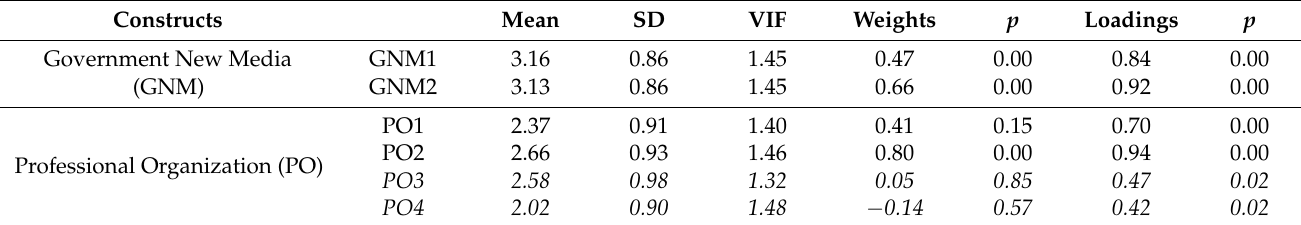
Table 4. Results of collinearity, weights, and item loadings.